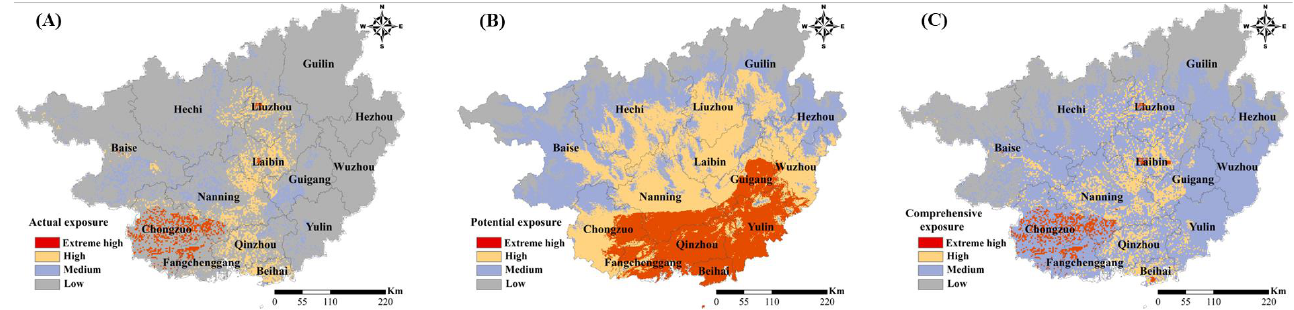
Figure 10. Spatial change in the drought exposure of sugarcane in Guangxi. ( A – C ) represent the Actual exposure, Potential exposure, and Comprehensive exposure, respectively.